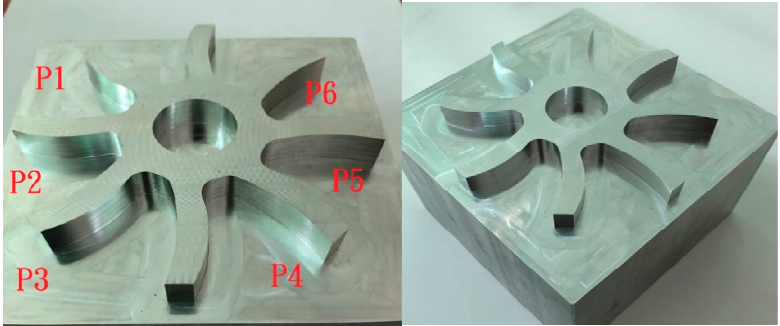
Figure 15. Contour surface milling sample for verification of predictive model. Table 9. Predictions of surface roughness in end milling process by ANN.